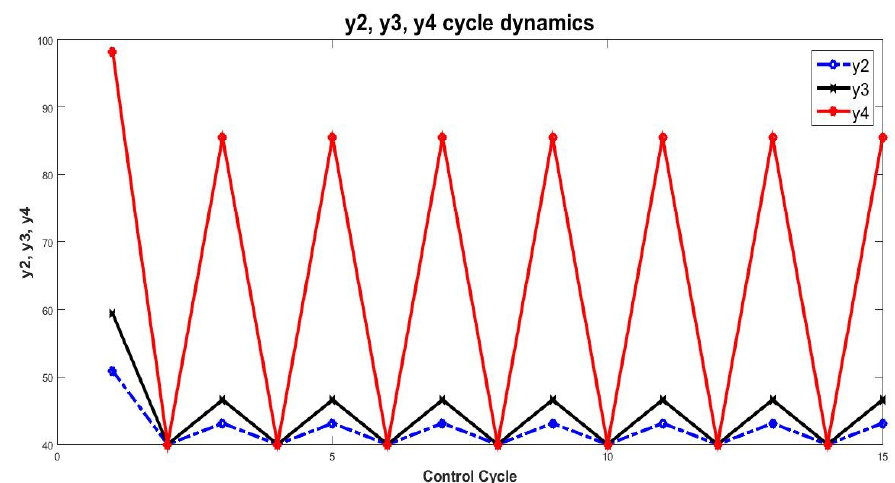
Figure 6. Dynamics of the cycles y 2 , y 3 , and y 4 .